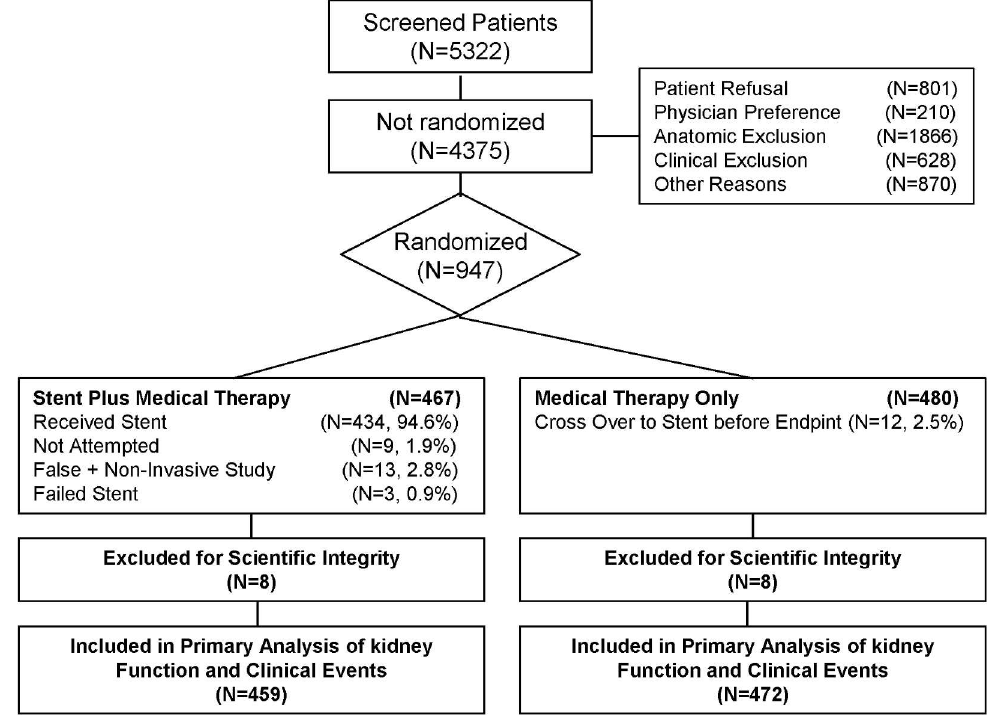
Fig 1. CONSORT flow diagram of CORAL